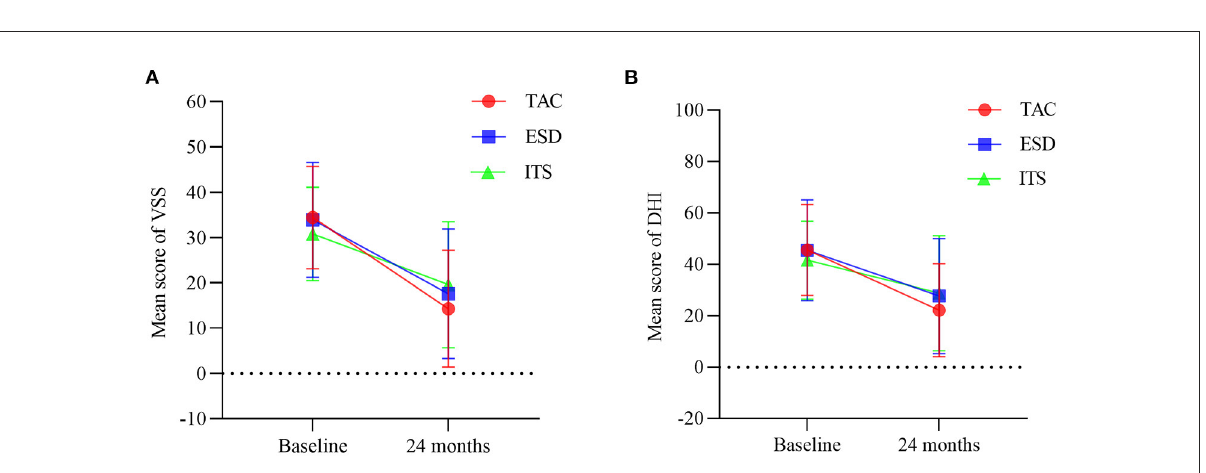
and VSS (decreased from 34.4 ± 11.3 ± 17.7 to 14.3 ± 12.9; t = 9.106, p < 0.001). However, we did not observe significant differences among the three groups for DHI score ( F = 1.674,